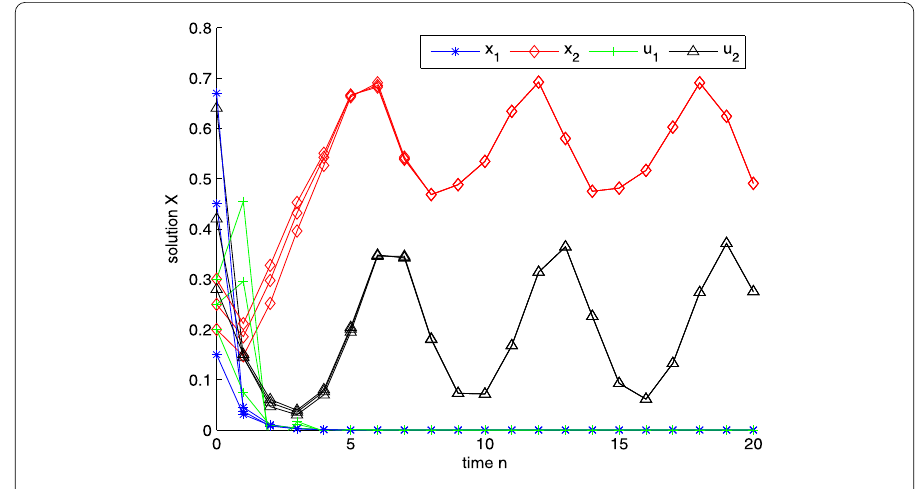
Figure 1 Dynamic behaviors of system (1.3) with initial condition ( x 1 (0), x 2 (0), u 1 (0), u 2 (0)) = (0.13,0.35,0.48,0.62),(0.45,0.75,0.67,0.42) and